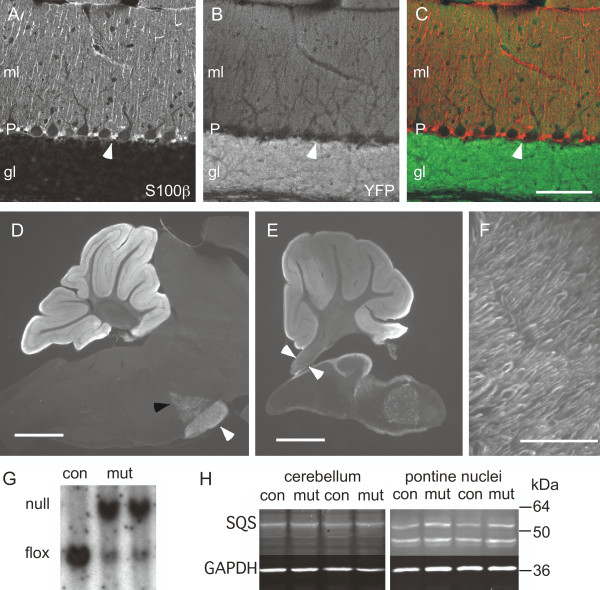
Conditional deletion of the fdft1 gene in vivo. (A-F) Expression of cre-recombinase in transgenic mice (Tg(mα6-cre)B1LFR) is illustrated by expression of yellow fluorescent protein (YFP) from the R26R-EYFP reporter allele. Vibratome sections of adult cerebellum were double-labeled for the Bergmann glia marker S100β (in A) and the recombination marker YFP (in B). Purkinje neurons (P) and interneurons in the molecular layer (ml) are identified as unstained "holes" (in A-C). YFP is exclusively expressed in granule cells of the granule cell layer (gl) and in their axons that form a weakly stained "lawn" of parallel fibers in the molecular layer. The merge in (C) highlights the lack of YFP expression in Bergmann glia (in red, arrow head). A single confocal plane is depicted, scale bar = 100 μm. (D-E) Overview of targeted cells in a triple transgenic mutant mouse (fdft1flox/flox, Tg(mα6-cre)B1LFR, YFP-reporter). Staining vibratome sections from an adult animal for YFP reveals that cerebellar granule cells, pontine nuclei (white arrow head in E) and reticulotegmental nucleus of the pons (black arrow head in E) survive into adulthood in the absence of squalene synthase. The YFP-positive axons from the targeted pontine neurons enter the cerebellum via the middle cerebellar peduncle (arrowheads in E) and blowup (in F). scale bar = 1 mm (in D-E) and 50 μm (in F). (G) 80 % of all cells in the cerebellum are recombined. Southern blot on total cerebellar DNA from a control (con) and mutant (mut) animals, age two months, was hybridized to a probe that recognizes distinct fragment sizes for the flox allele (flox) and the recombined null allele (null). (F) The level of squalene synthase protein is not significantly reduced in vivo at postnatal day 16. A western blot of total cerebellar lysate (cerebellum) or the pontine nuclei from two controls (con) and two mutants (mut) was probed for squalene synthase (SQS) and glyceraldeyde-3-phosphate dehydrogenase (GAPDH) as a loading control. Apparent molecular weights are indicated on the right. Squalene synthase was consistently detected as a doublet in the pontine nuclei, but not in cerebellum or cortex (data not shown).